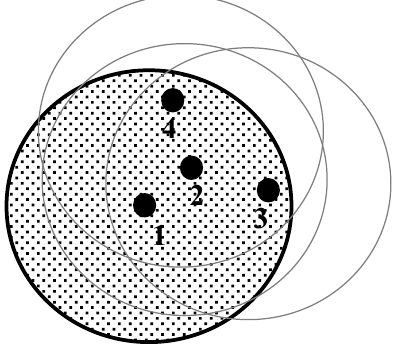
Figure 6. Neighbour’s area of